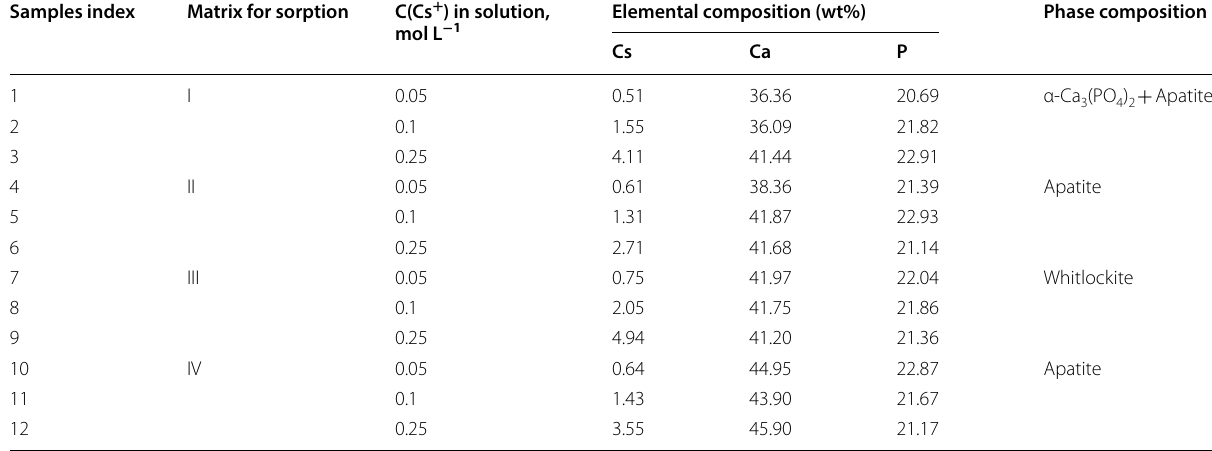
Table 3 Chemical and phases composition of obtained complex substituted calcium phosphates after sorption and heating to 700 °C depending on both type of initial matrix and concentration of cesium ion in the solution